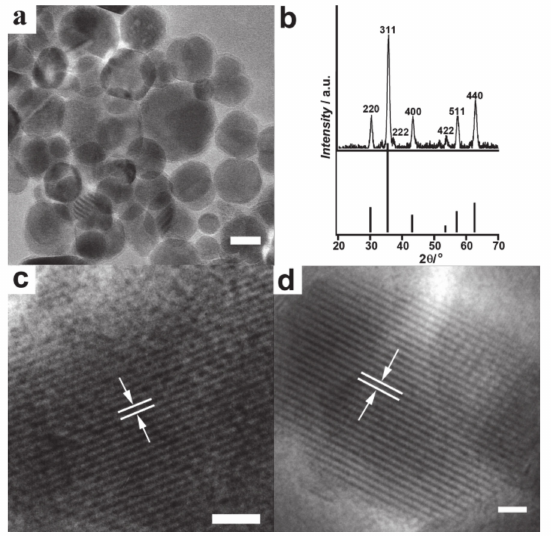
Figure 3. TEM ( a ), XRD ( b ) and HRTEM ( c , d ) analysis of as-prepared Fe 3 O 4 nanoparticles. ( a ) TEM analysis of Fe 3 O 4 nanoparticles with scale bar equal to 20 nm. ( b ) Powder XRD pattern of as-prepared Fe 3 O 4 NCs by Scheme 3, the vertical line on the bottom corresponds to face centered cubic Fe 3 O 4 (PDF = 75-0033). ( c , d ) HRTEM of Fe 3 O 4 resolving the lattice spacing of the (220) plane is 3.0 ± 0.2 Å and (111) plane is 5.0 ± 0.2 Å. The scale bar in HRTEM images is all equal to 2